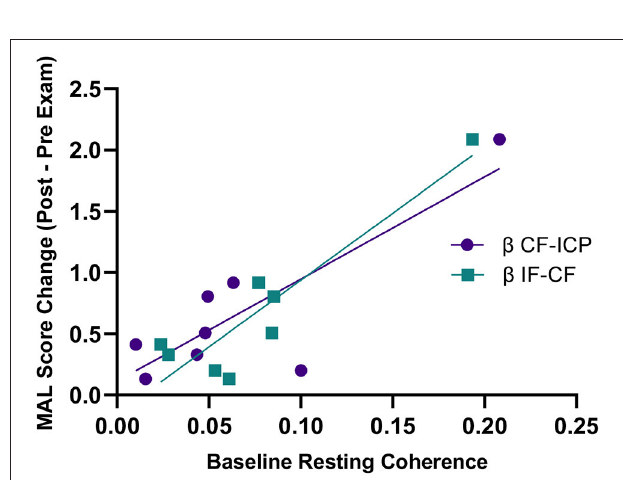
FIGURE 6 | Baseline resting state coherence vs. change in MAL score from pre to post-HandSOME II therapy. Greater baseline β IF-CF and CF-ICP resting state coherence correlated with greater MAL gains ( p = 0.012, R 2 = 0.84 and p = 0.006, R 2 = 0.70,